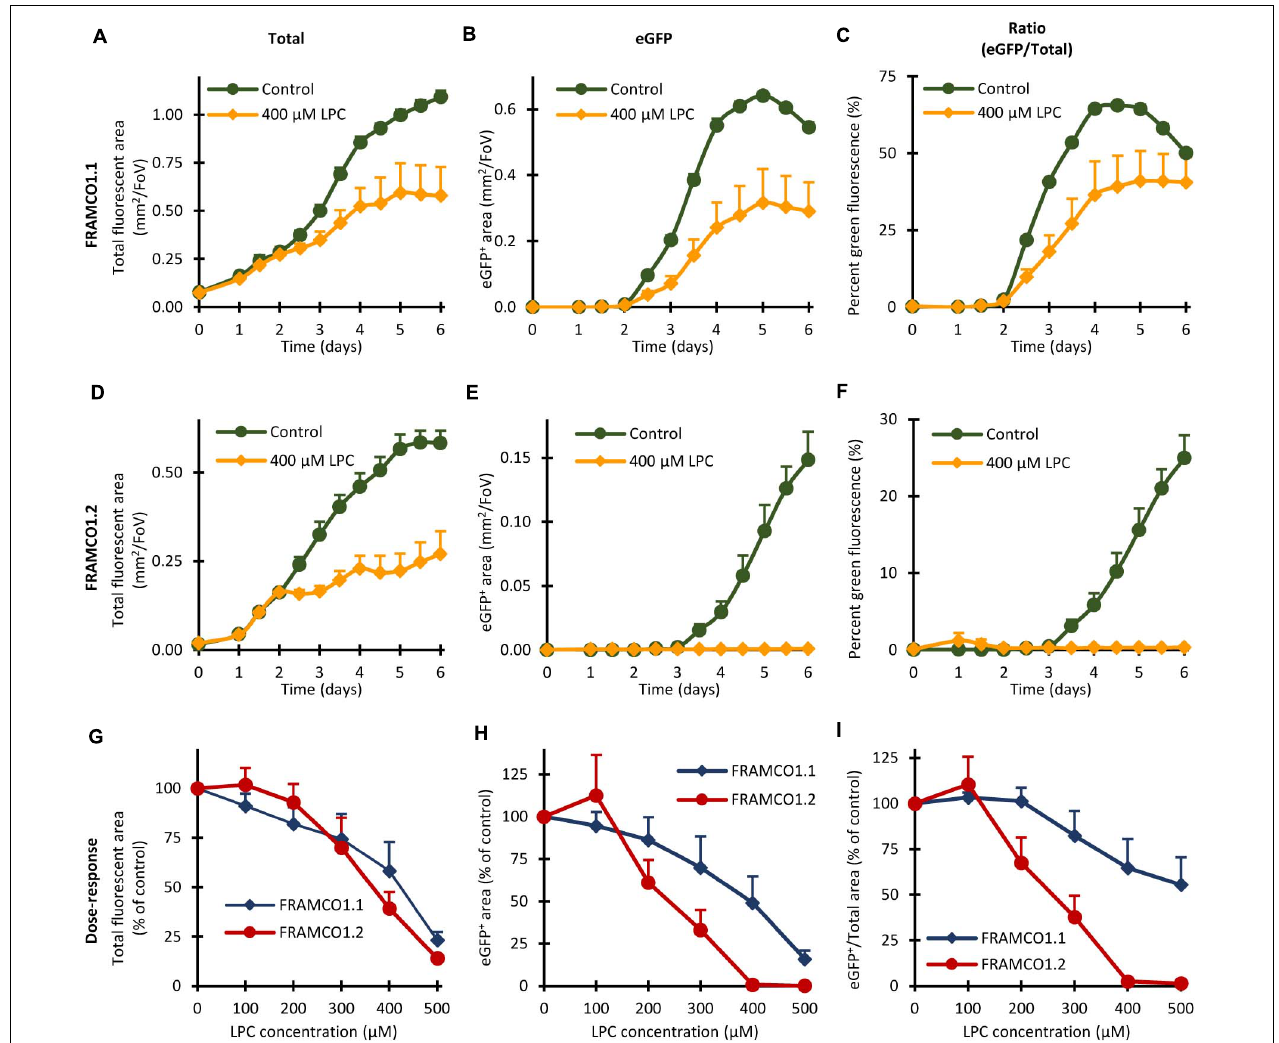
FIGURE 11 | Effect of Lysophosphatidylcholine (LPC) in the FRAMCO1.1 and FRAMCO1.2 assays. (A–F) Time course of changes in total (tdTomato + eGFP) fluorescent area (A,D) , green (eGFP-positive) fluorescent area (B,E) or in the green area as percentage of the total fluorescent area (C,F) in the absence or presence of 400 µ M lysophosphatidylcholine (LPC) as detected in Ctsk-Cre/mTmG (FRAMCO1.1, A–C ) or Ctsk-Cre + mTmG (FRAMCO1.2, D–F ) osteoclast cultures. (G–I) Dose-response curves of the FRAMCO1.1 and FRAMCO1.2 assays showing total fluorescent area (G) , green (eGFP-positive) fluorescent area (H) and the latter as percentage of the former (I) on Day 5 in the presence of the indicated LPC-concentrations. Values in (G–I) are shown as percentage of the controls not treated with LPC. Mean and SEM of six independent experiments is shown.